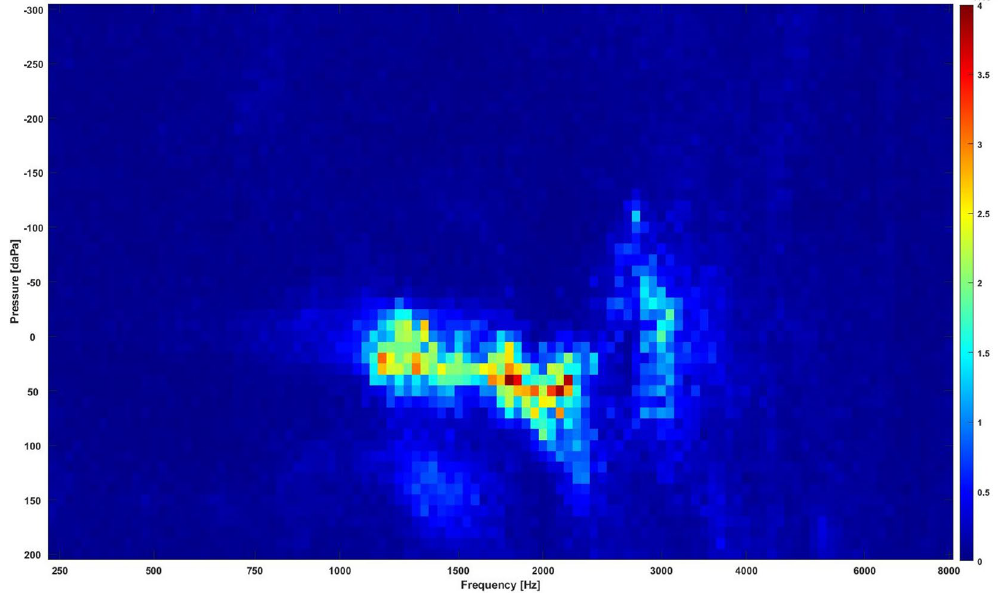
Figure 4. The extracted discriminative regions in the WAI data using the RF classifiers. Regions with high values (bright regions) are the most discriminative